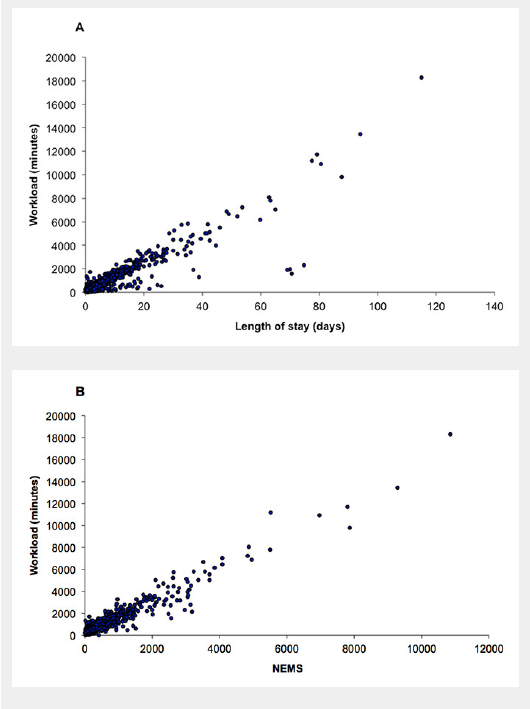
Bivariate scattergram for the relationship between workload and LOS (fig. 1A) and between workload and NEMS (fig. 1B). (n =